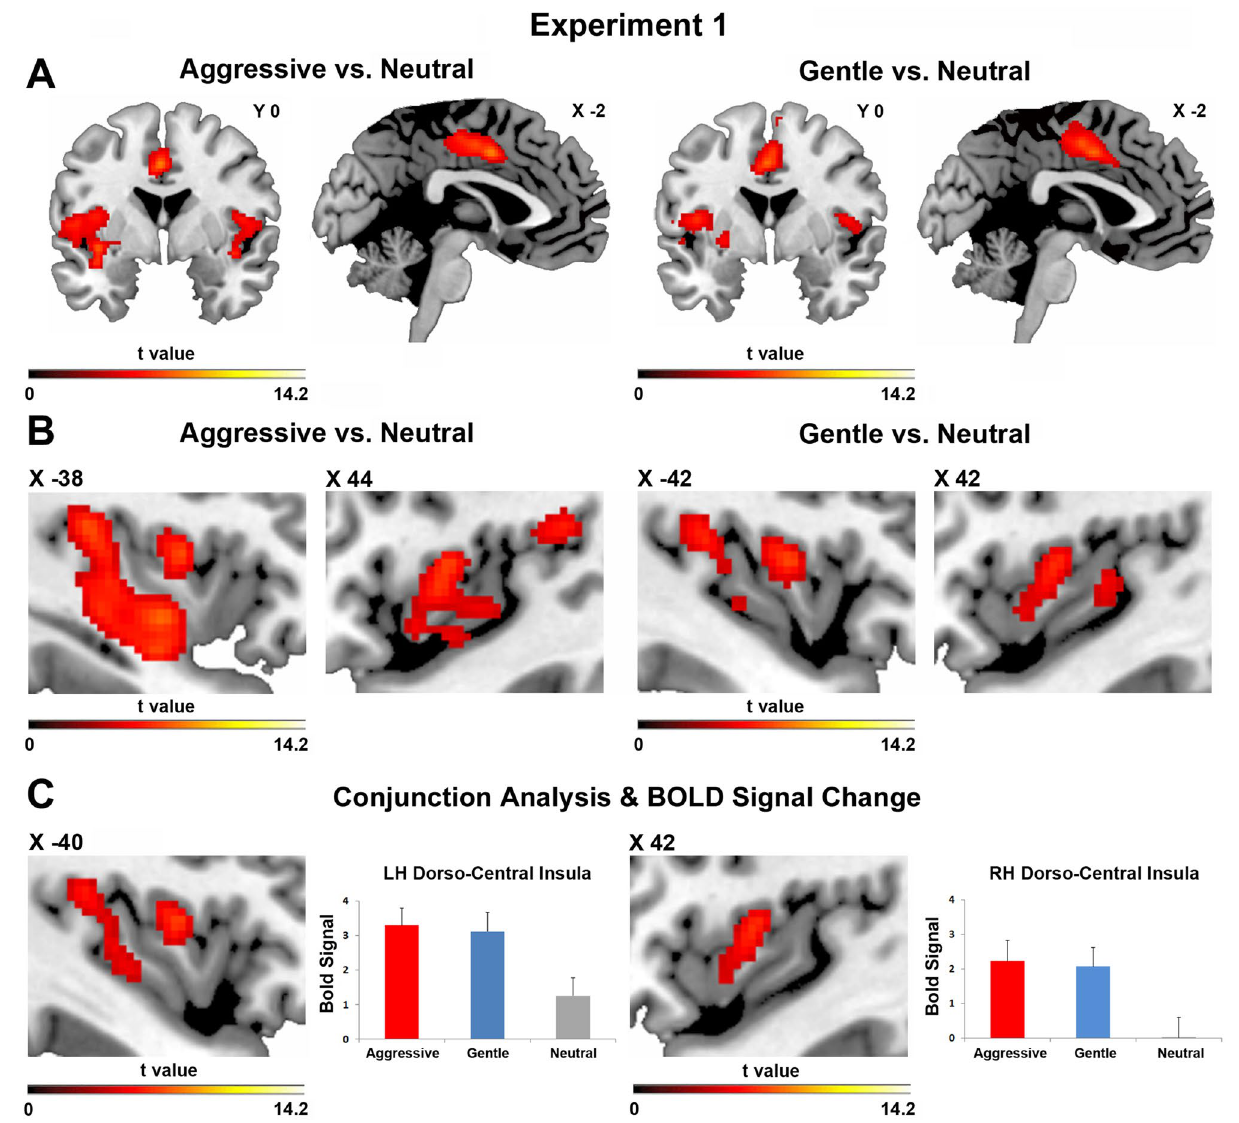
Figure 4. Parasagittal sections showing the activations of the insular and cingulate cortices obtained in situation 1 (handshake and facial expression) for the contrasts aggressive tactile vitality form vs. neutral tactile vitality form (aggressive vs. neutral) and gentle tactile vitality form vs. neutral tactile vitality form (gentle vs. neutral) ( A , B ). The conjunction analysis between the contrasts aggressive tactile vitality form vs. neutral and gentle tactile vitality form vs. neutral revealed a common activation of the dorso-central sector of insula ( C ). The bars presented on the right side indicate the BOLD signal change extracted from the left and right dorso-central insula. These brain activations are rendered using a standard Montreal Neurological Institute brain template (P FWE < 0.05 at cluster